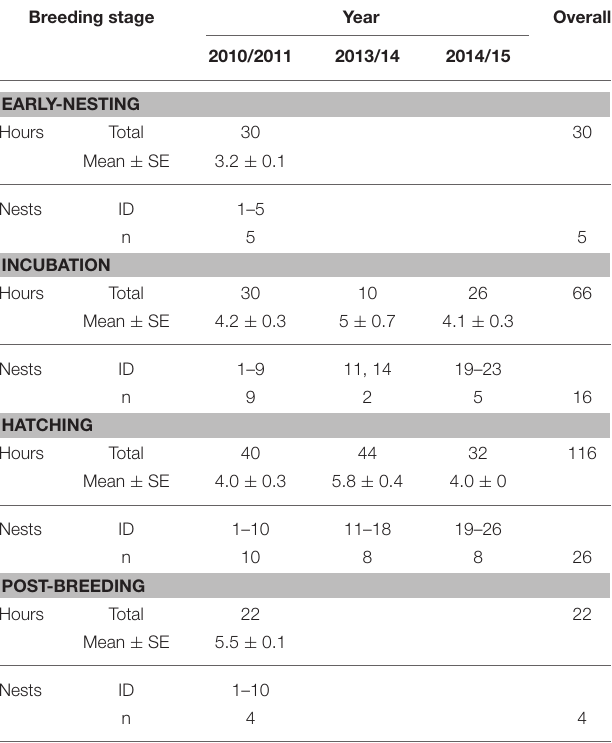
TABLE 1 | Summary of nest observations over the 3 years of the